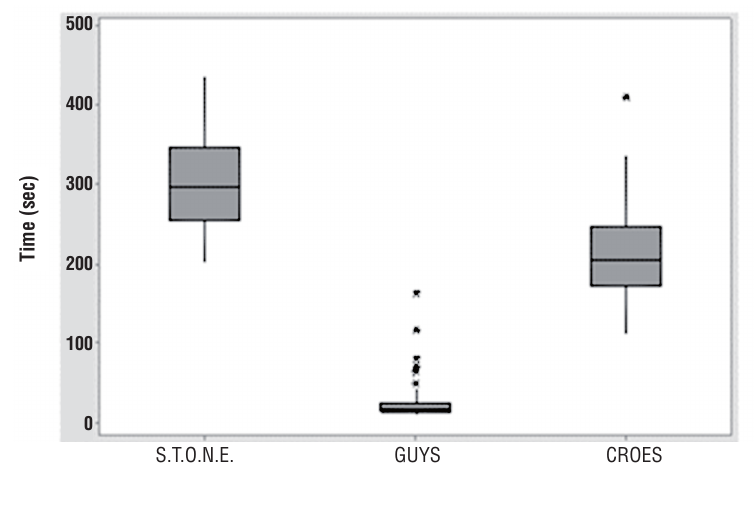
figure 1 – Time of application of the nomograms (in seconds).